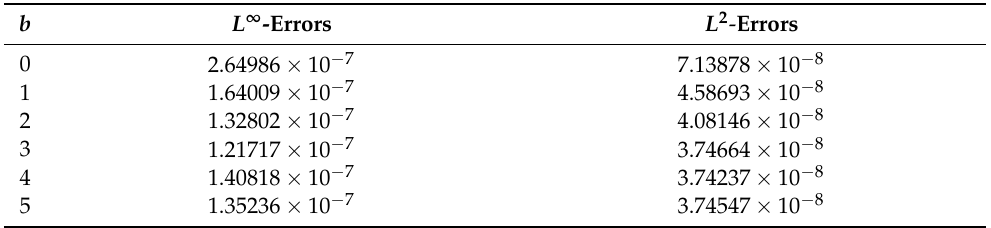
Table 7. Comparison of L ∞ - and L 2 -errors of our algorithm at υ 1 = 0.5 and N = 20 with distinct b for Example 4.